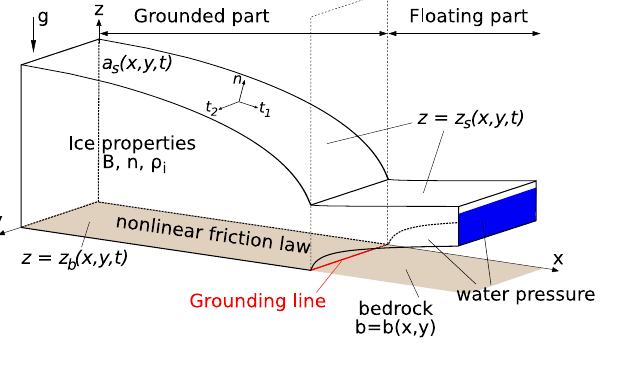
Fig. 1. Main characteristics of the modelled geometry.